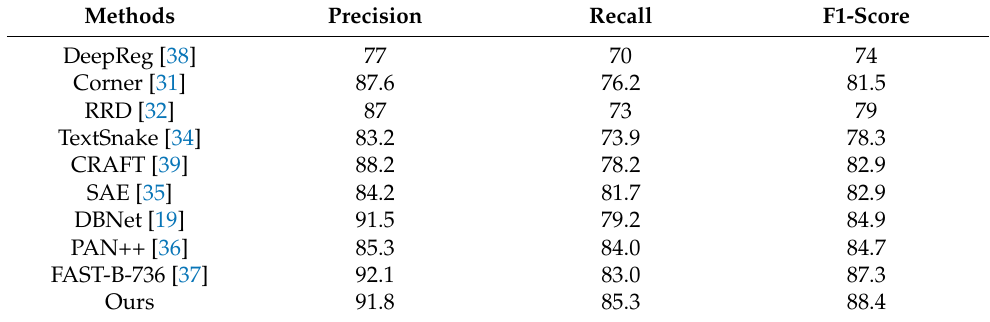
Table 2. Results of MSRA-TD500